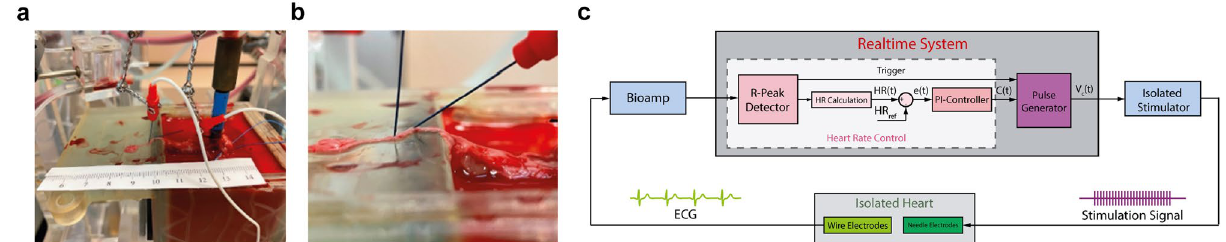
Figure 2. Overview of the experimental setup. ( a ) Isolated heart preparation with needle electrodes inserted into the vagus nerve for stimulation and wire electrodes inserted into the base of the right atrium to measure the electrocardiogram. ( b ) Zoomed-in image of the needle electrodes inserted into the vagus nerve next to the superior cardiac branch with the cathode caudal and the anode cephalad. ( c ) Schematic overview of the hardware-in-the-loop implementation of the control strategy. Reference heart rate, HR ref , measured heart rate, HR(t), calculated error, e(t), current amplitude, C(t), control voltage for the isolated stimulator V c